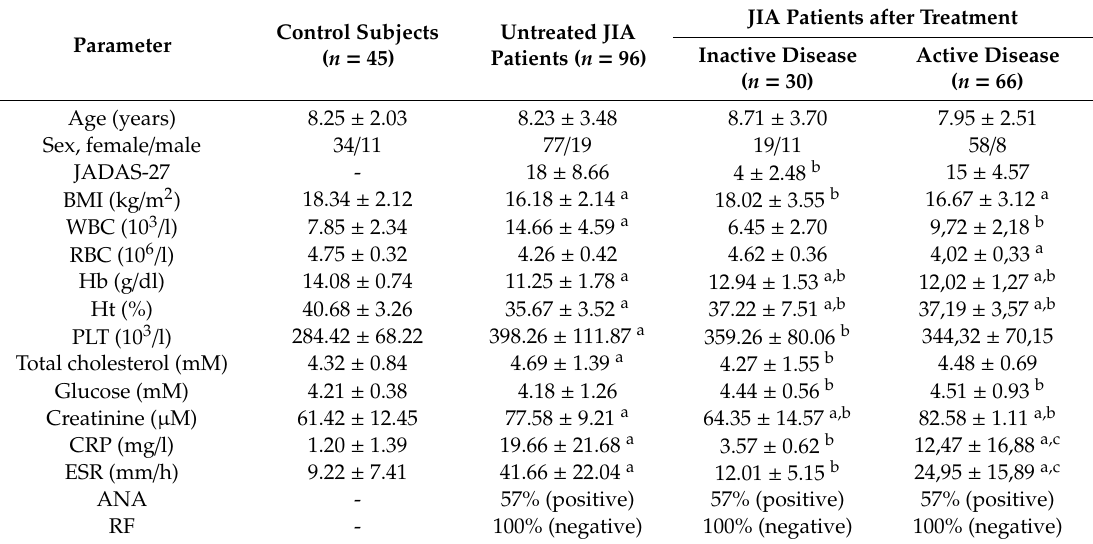
Table 3. Clinical characteristics of control subjects and JIA